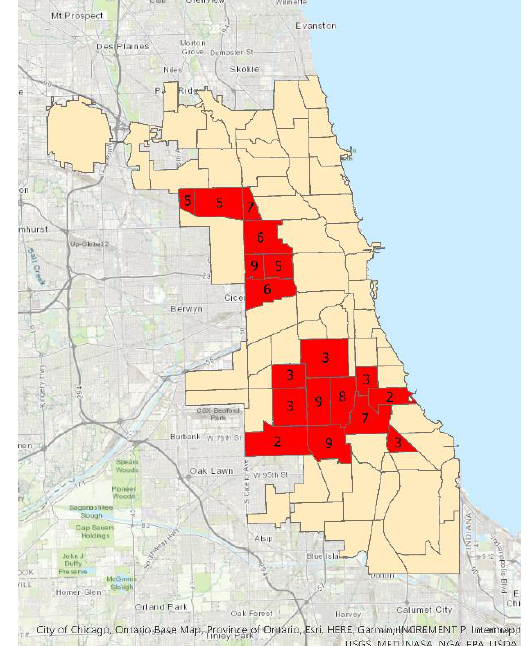
Figure 11. High value clusters by 2-hour interval in a day at community level